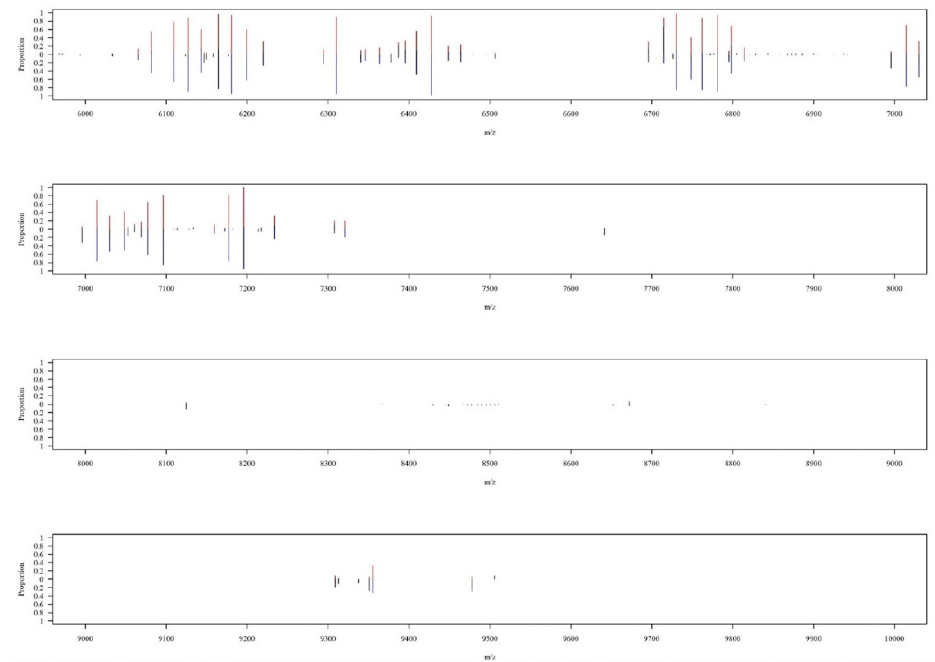
Figure 4. Zoomed-in view on MALDI − TOF spectrum over m / z 2000 to 6000. A zoomed-in detailed view over the range of m / z 2000 to 6000. The x -axis represents the mass-to-charge ratio ( m / z ) from 2000 to 6000. The y -axis shows the proportion of occurring frequency in all corresponding isolates at specific peaks, while red lines represent M. massiliense , and blue lines represent M. abscessus . For example, at peak of m / z 3008, red line (i.e., M. massiliense ) appears in about 60% of subsp. massiliense isolates, whereas the blue line (i.e., M. abscessus ) shows the occurring frequency is only 20%.